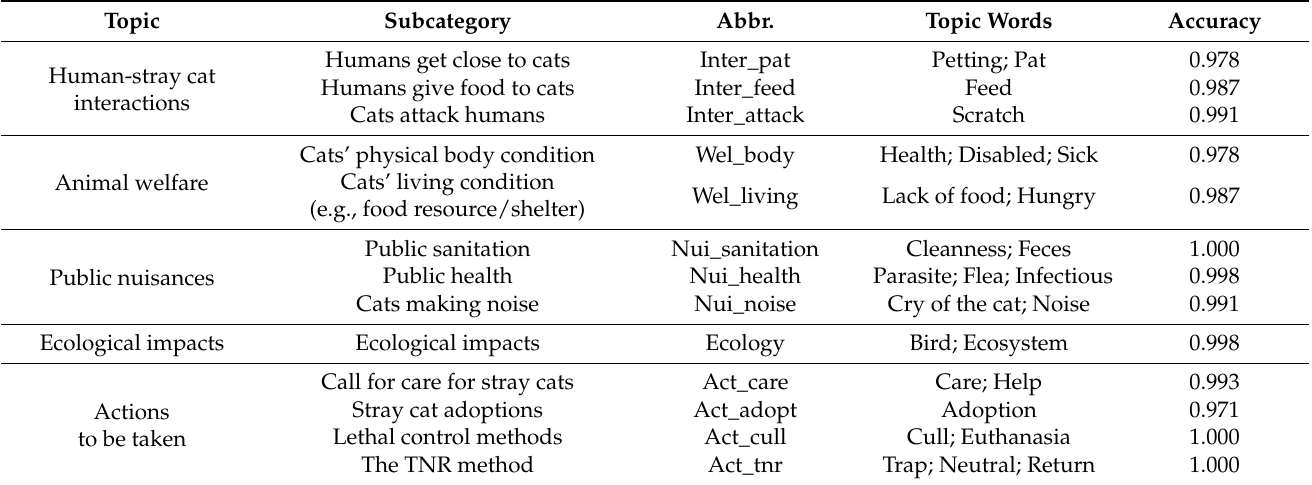
Table 2. Public opinions on stray cats can be classified into five topics. The performance of lexicons in topic identification was presented in accuracy scores. A portion of topic words (keywords within each subcategory) was